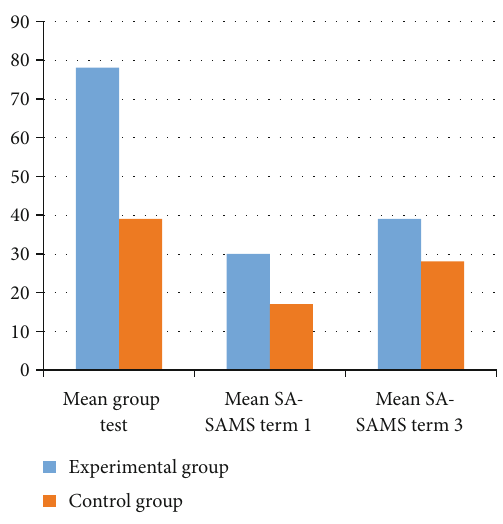
Figure 18: Comparison of group test and SA-SAMS